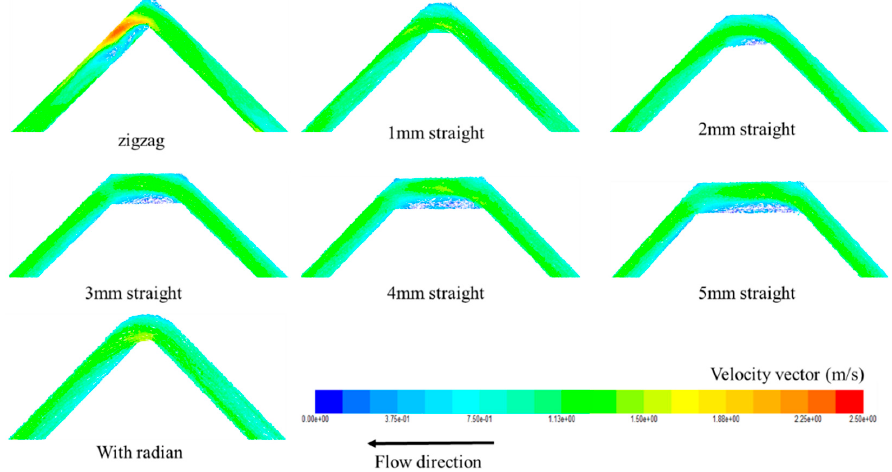
ff erent channel shapes.